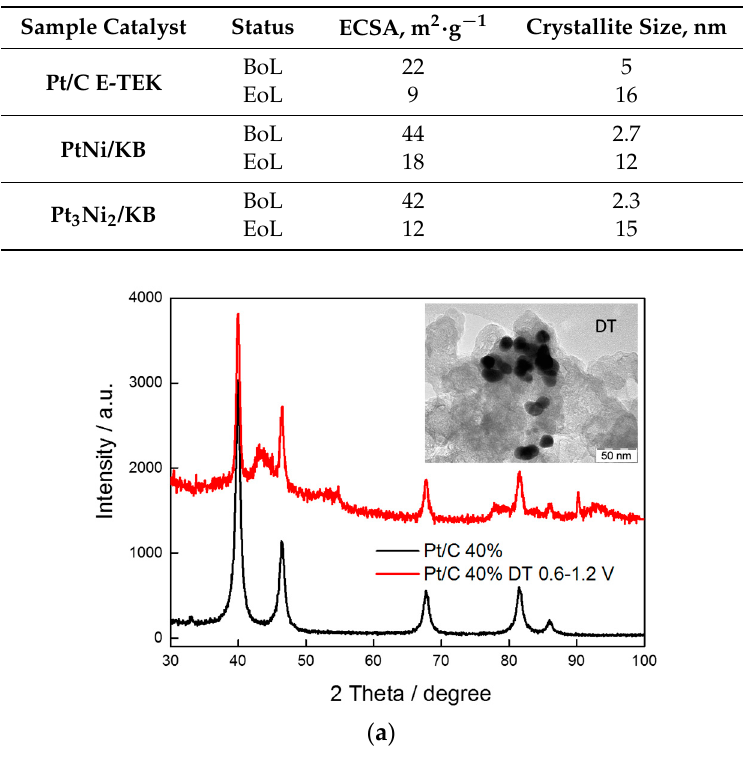
Figure 8. Histogram reporting the cell potential at 200 and 900 mA · cm − 2 for the MEAs based on the different cathodic catalysts before and after the ADT. Table 4. Electrochemical active surface area and crystallite size at the beginning and end of life for the different MEAs.